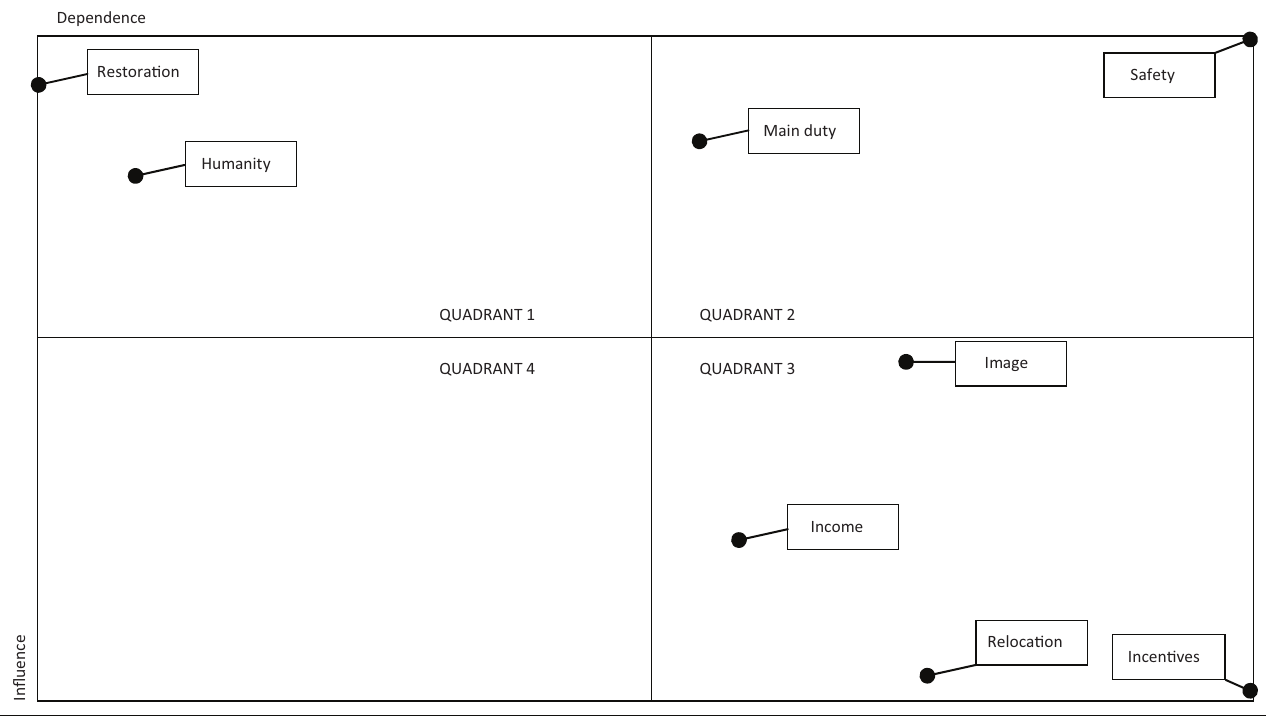
FIGURE 2: Map influence and interdependence between the objectives of